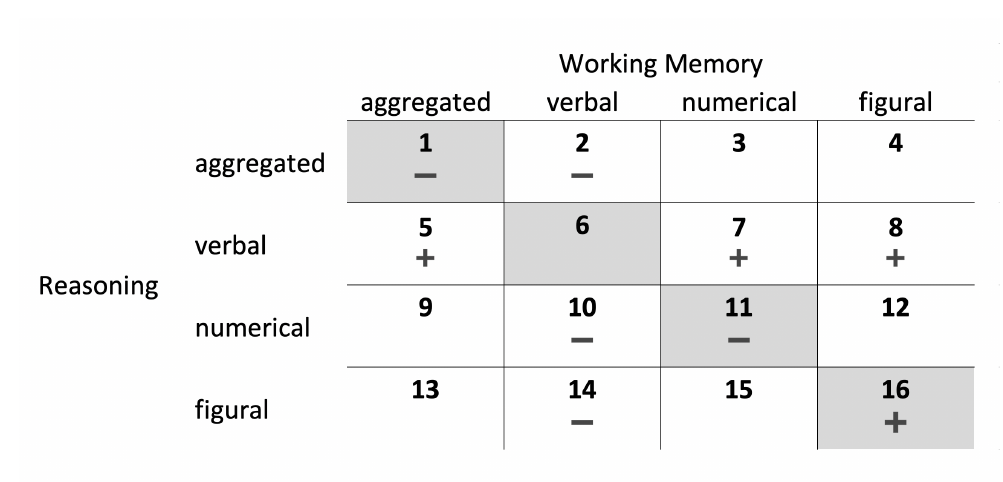
Figure 2. Conditions numbered from 1 to 16 as combinations of different aggregation levels and contents of the operationalizations investigated in the present study (each condition with two models; see Figure 3). Gray-shaded conditions were examined in Zech et al.’s (2017) study and represent symmetrical (fair) combinations in terms of the predictor-predictor symmetry as similar operationalizations of working memory and fluid reasoning were considered. The other conditions can be considered as potentially asymmetrical (unfair) in terms of the predictor-predictor symmetry as different aggregation levels or contents were considered. Ad-hoc expectations whether working memory incrementally explains variance above and beyond fluid reasoning (+) or not ( − ) are displayed for each condition.